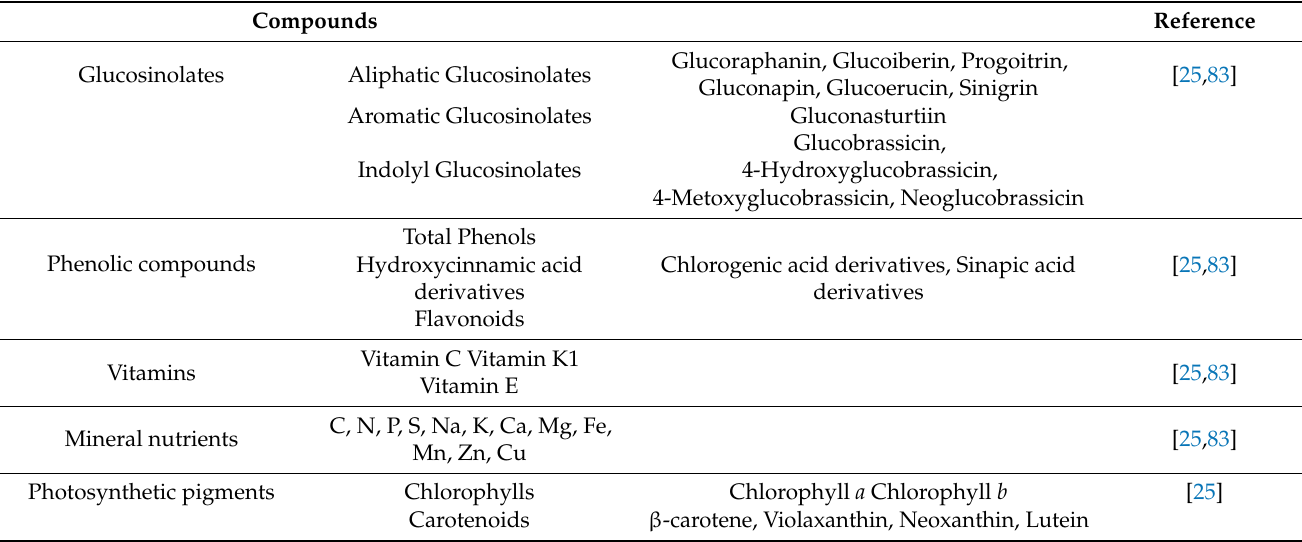
Table 1. Major compounds present in broccoli by-products (leaves and